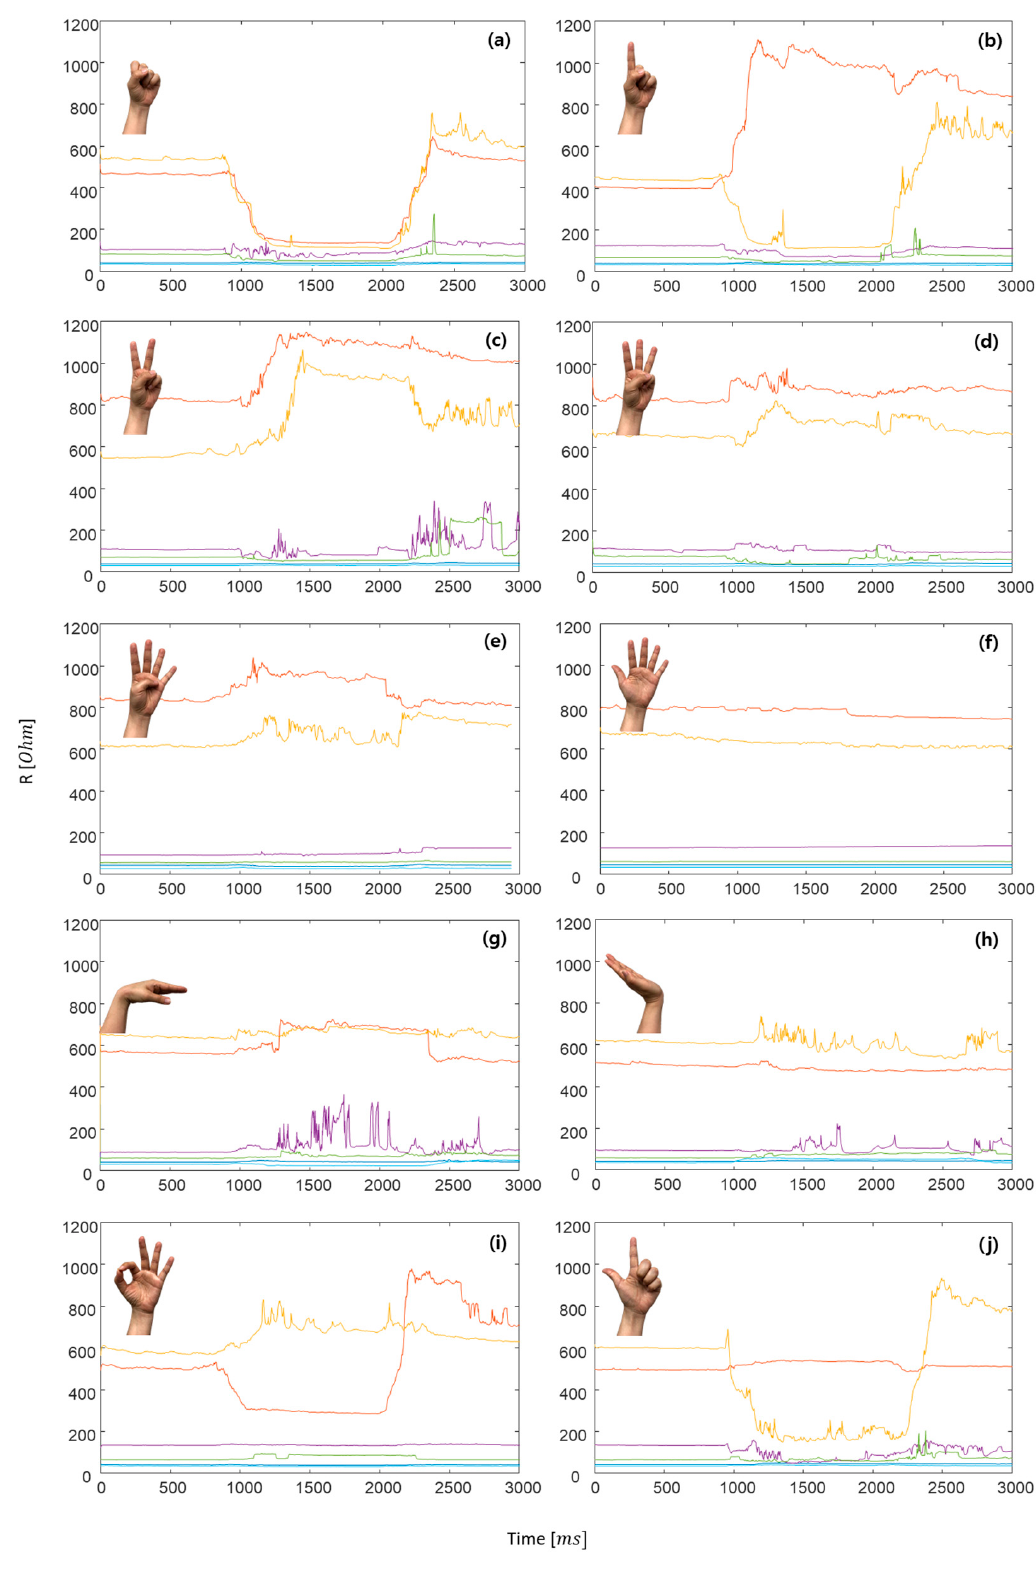
Figure 10. Electrical resistance variations according to 10 hand postures, where ( a ) grasp, ( b ) one, ( c ) two, ( d ) three, ( e ) four, ( f ) five (resting posture), ( g ) wrist flexion, ( h ) wrist extension, ( i ) okay, and ( j ) pinch, and ms stands for milliseconds.